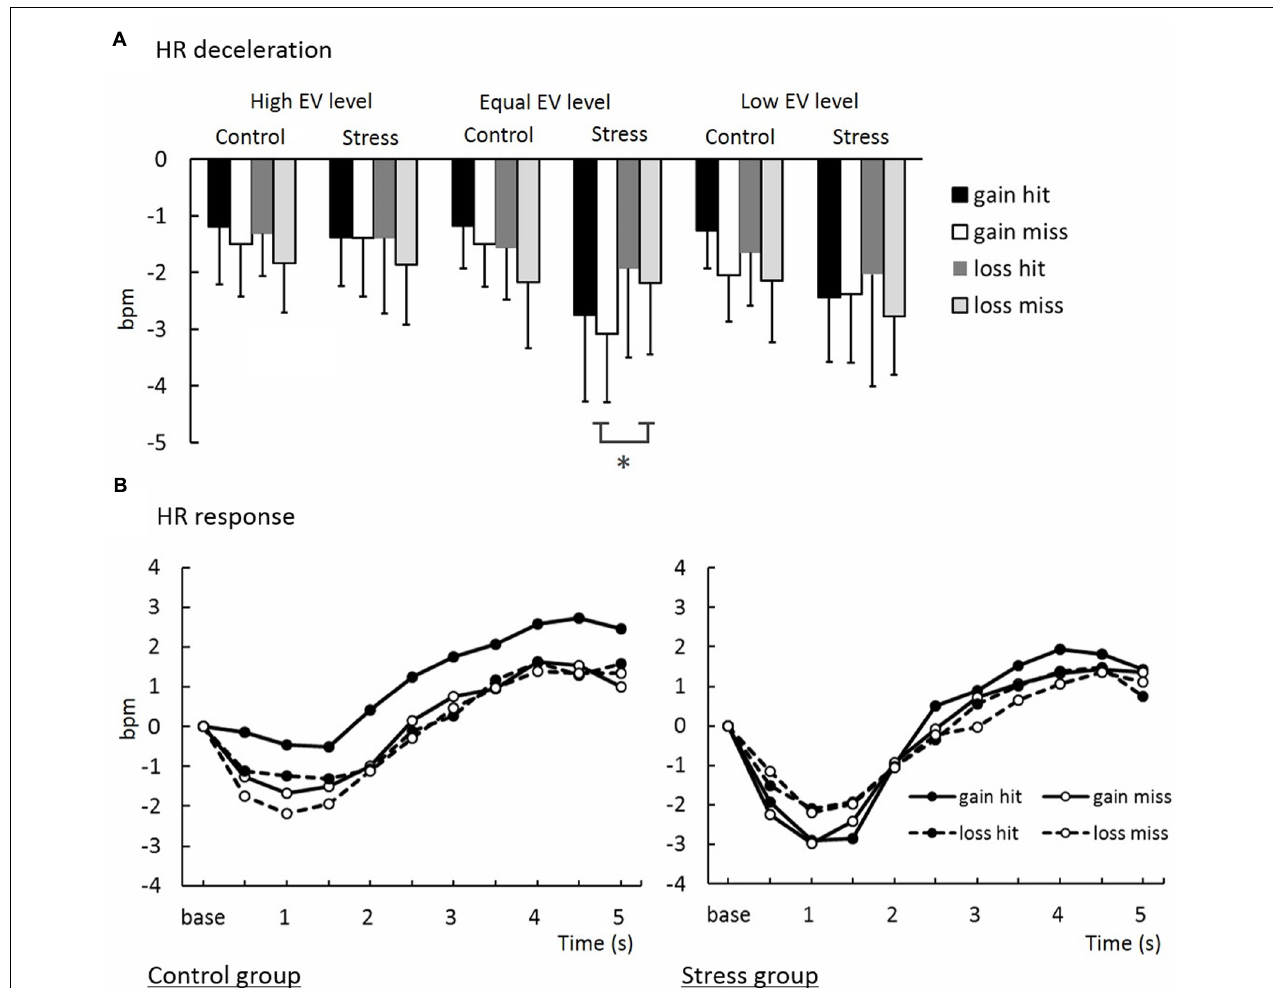
FIGURE 7 | (A) Heart rate deceleration in decision-making task. ∗ Significant difference between groups ( p < 0.05). (B) Waveforms of time-series variations of HR